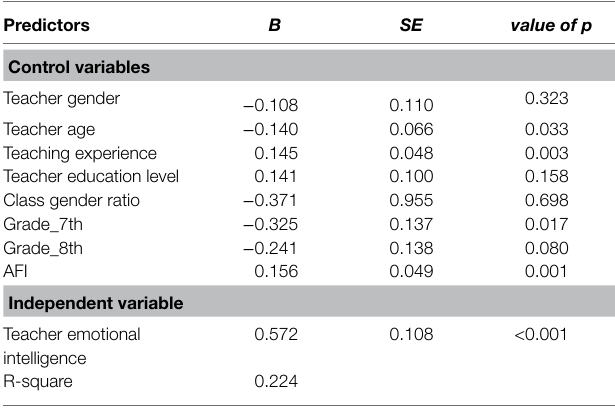
TABLE 2 | Total effect of teacher EI on student academic achievement.